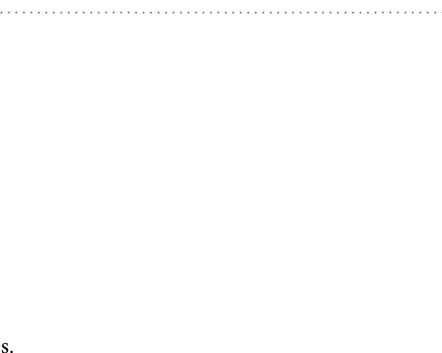
Figure 1. Comparisons of the α -diversity indices. Rarefaction curves for OTU ( a ) and Shannon index ( b ) with the sequences normalized to 30,707 reads.